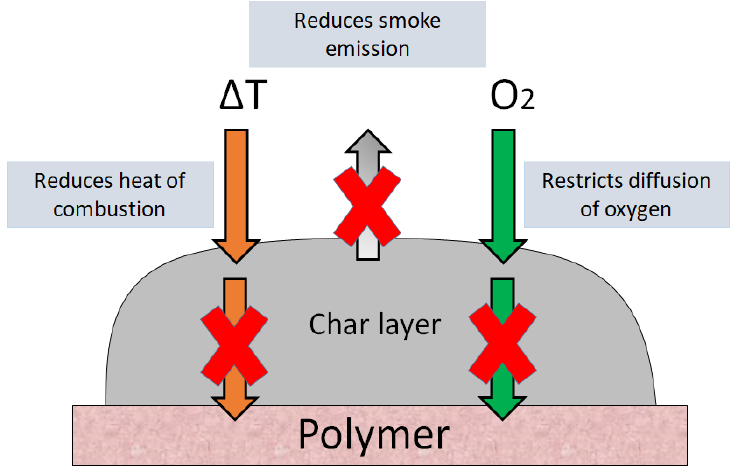
Figure 4. Action mechanism of intumescent flame retardants.